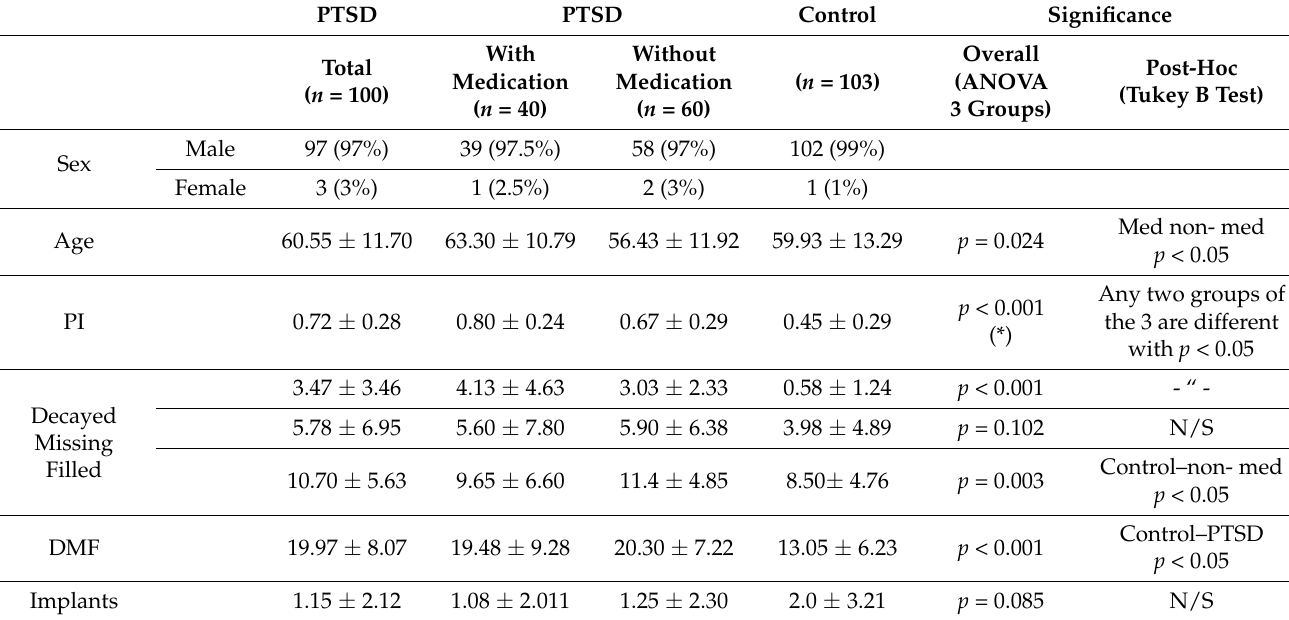
Table 1. A description and comparison of demographic and quantitative variables of PTSD patients with/without medications and a control group. Control